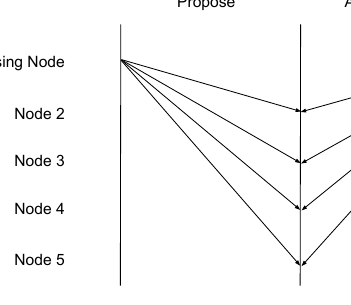
Figure 5. Conte Single Round Block Commit.